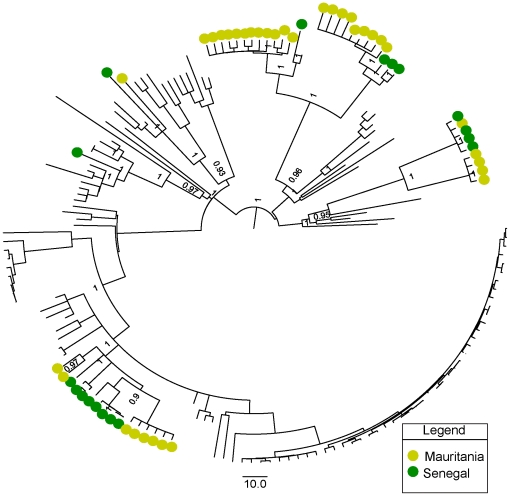
Maximum clade credibility (MCC) tree for the short (S) segment.Relationship among 167 strains of RVFV isolated from different localities and countries. Samples from Mauritania and Senegal are shown by green and yellow dots respectively. The recurrent independent clustering of green and yellow dots suggests multiple introductions of RVFV into these countries throughout the 20th century. Posterior probability values greater than 90% are shown near tree nodes.